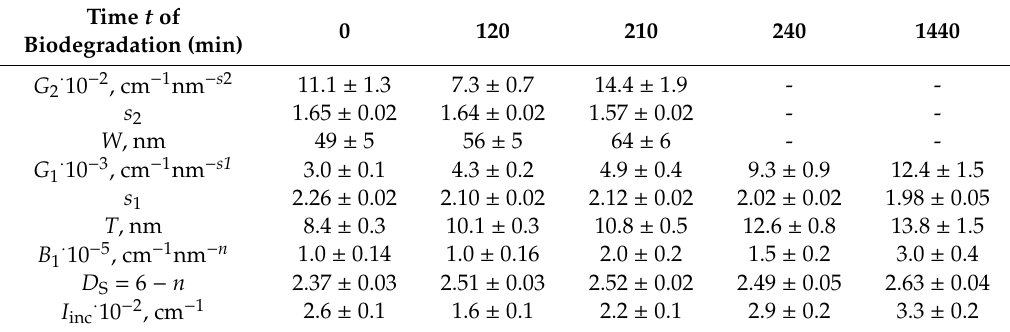
Table 2. Parameters of the mesostructure of the supercritically dried samples of BC after the biodegradation under the action of cellobiohydrolase from S. candidum 3C derived from the analysis of ultra-small angle neutron scattering (USANS) and small angle neutron scattering (SANS) data.